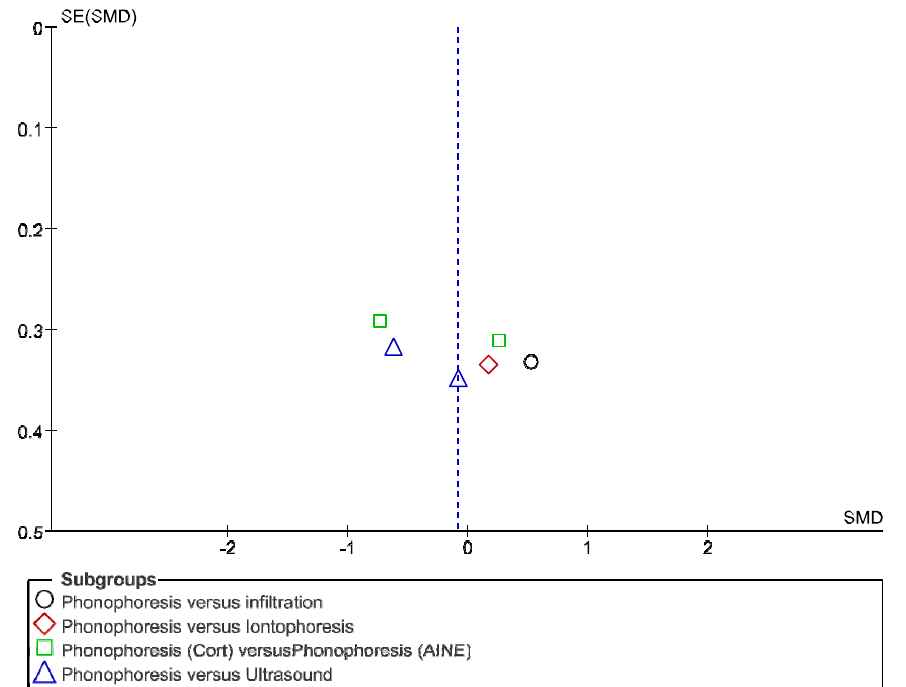
Figure 15. Phonophoresis for BCTQ Sensorial.